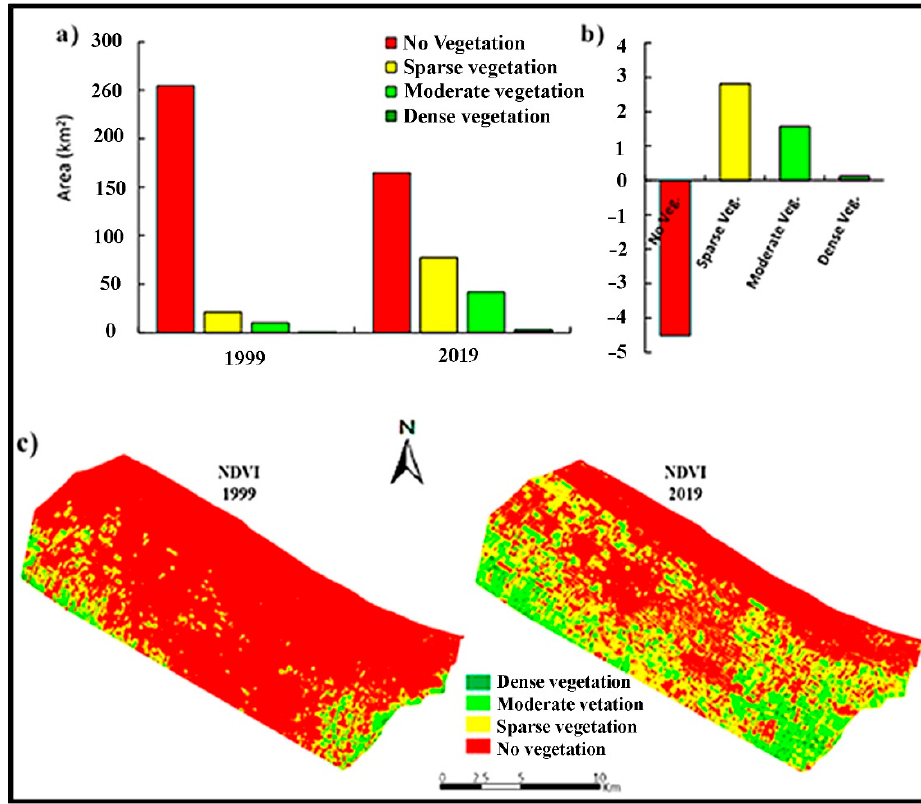
Figure 6. Areas in sq. km of NDVI classification for Deltaic Mediterranean Coast of the study area; ( a ) classification comparison from 1999 to 2019, ( b ) annual rate of change for each class, and ( c ) NDVI distribution map.